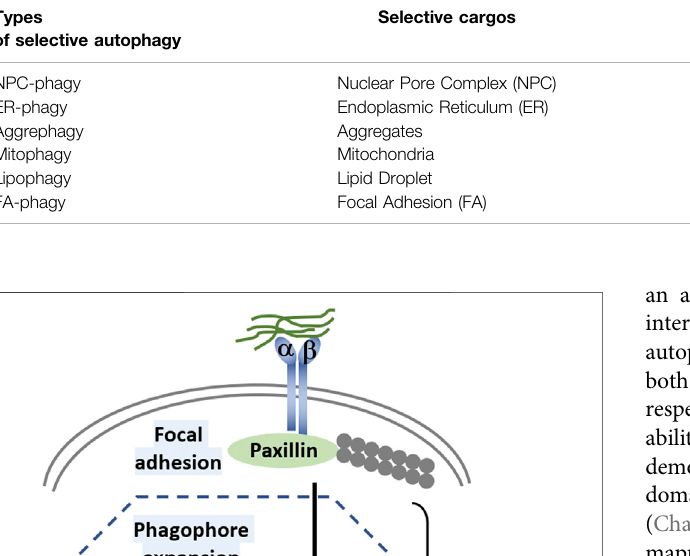
TABLE 1 | Types of selective autophagy/organellophagy and cargo receptors.